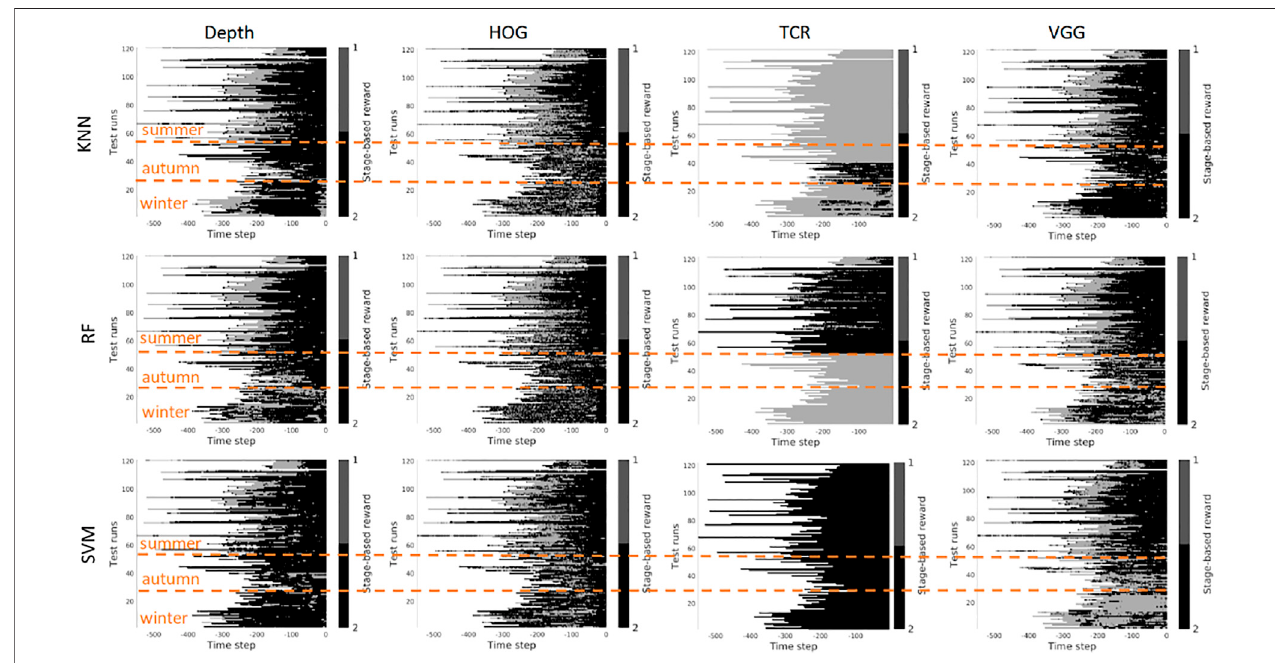
FIGURE 9 | Stage-based reward plotted for all seasons. Scenario 1: trained on the summer set of data D summer , 2 stages. The stages proceed as follows: S 1 − > S 2. x -axis stands for the time step in reversed order to match the samples of varying length. Color bar encodes the stages: S 1 -gray, S 2 - black.